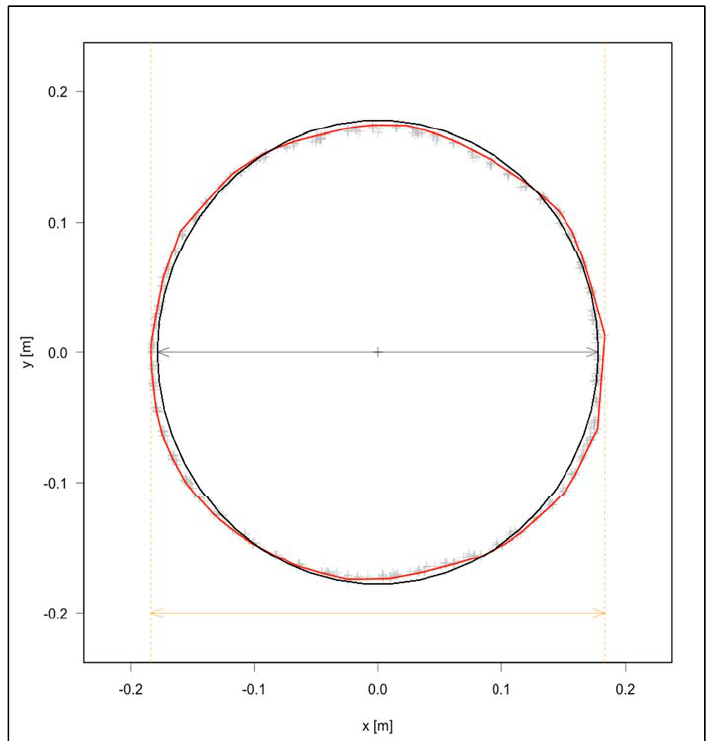
Figure 2. Comparison of circle-fitting (black) versus convex-hull-based (orange) diameter estimation. In the considered direction, fitting a circle to the points (grey crosses) registered as ‘stem surface’ in this section leads to an underestimate of the diameter, while the convex-hull-based diameter simulates a high-precision tree caliper measurement. In the orthogonal direction, circle diameter is clearly larger than the stem section while the convex-hull-based diameter will provide a more accurate